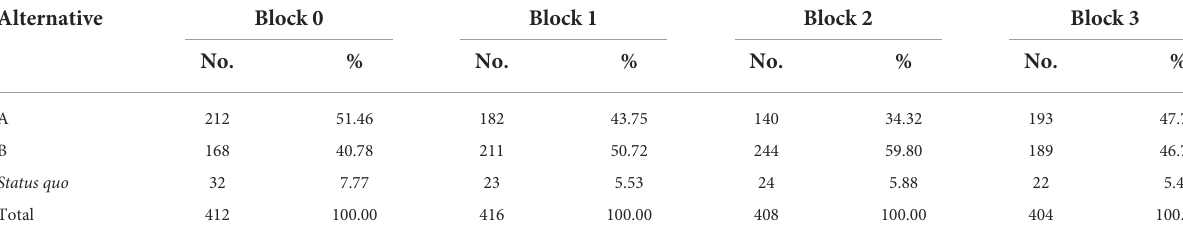
TABLE 5 Distribution of the alternatives chosen by block.